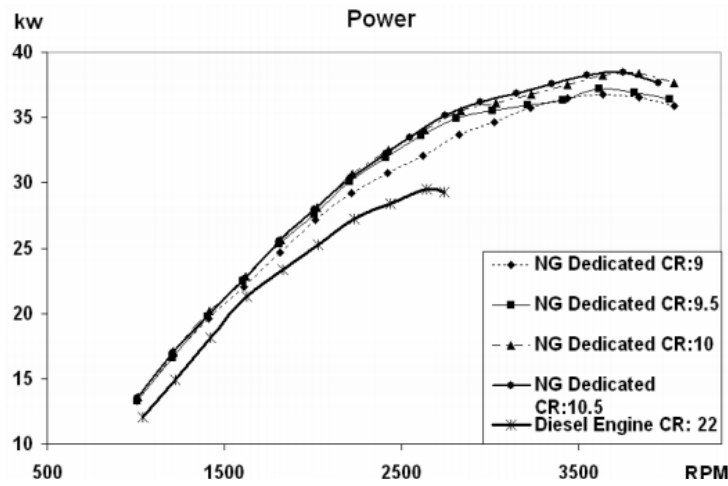
Figure 10. Brake power of CNG fuel at four different compression ratios and of diesel fuel [199].